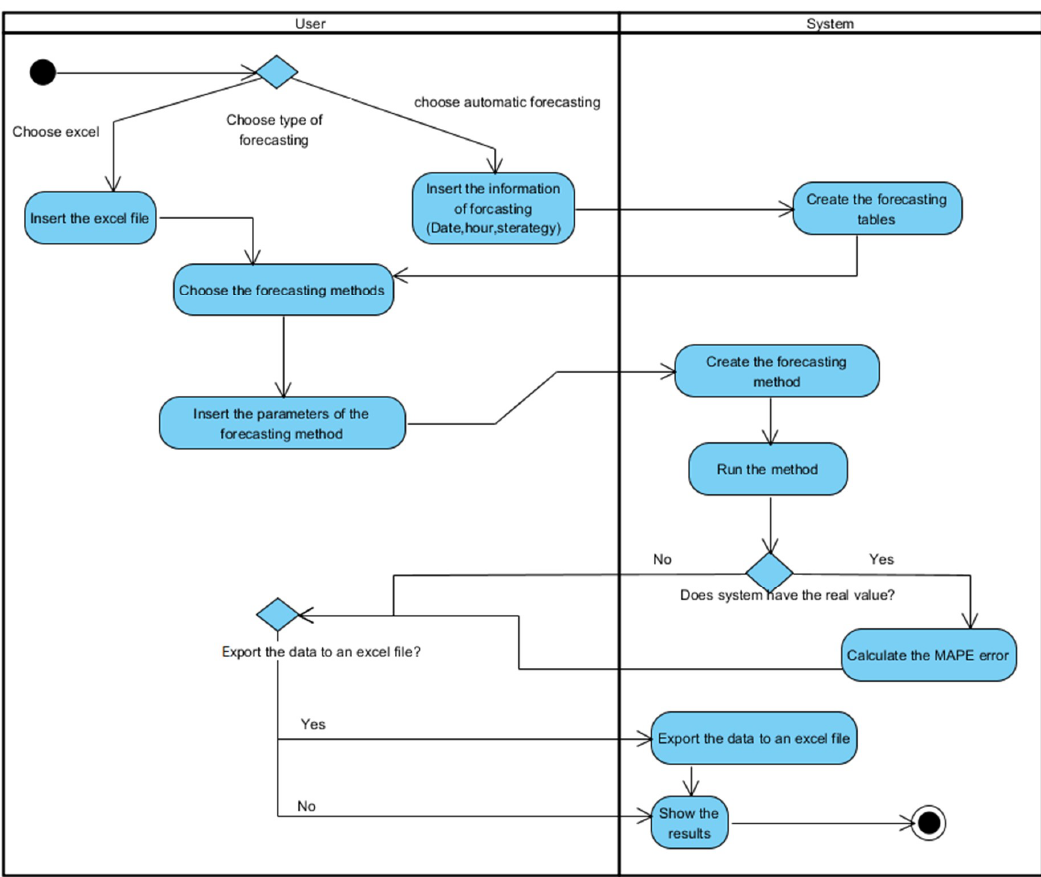
Figure 7. Activity diagram of the application.